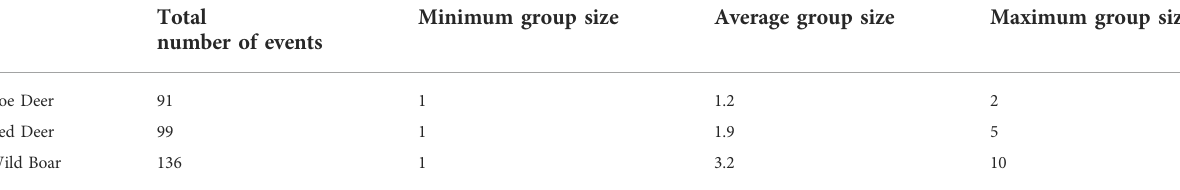
TABLE 1 Summary of number of events and group sizes for each